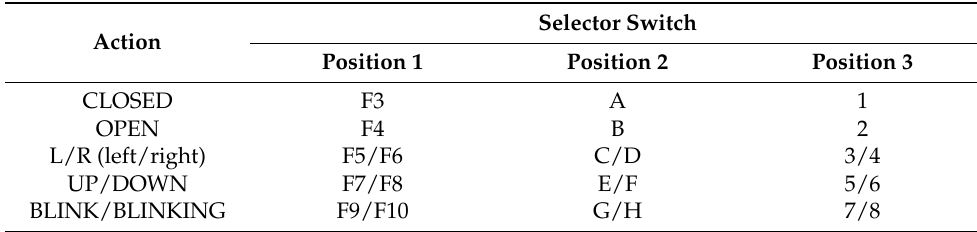
Table 1. The keyboard shortcuts associated with the corresponding ocular artifacts and the position of the selector